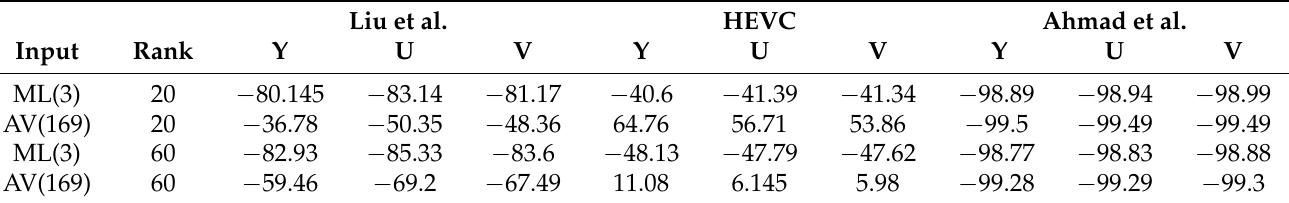
Table 8. Bjontegaard percentage rate savings for the proposed compression scheme with respect to Liu et al., HEVC codec, and Ahmad et al. on Bikes data with (ML(3)) and without (AV(169)) multiplicative layers for ranks 20 and 60 (negative values represent gain over anchor). Liu et al. HEVC Ahmad et al.